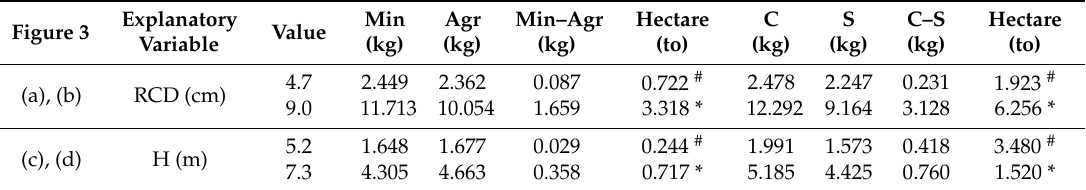
Table 7. Comparison of different former utilization and growth type models, by using the value of 4.7 cm and 9.0 cm for RCD and 5.2 m and 7.3 m for H, Min = Mining, Agr = Agriculture, C = Core, and S =